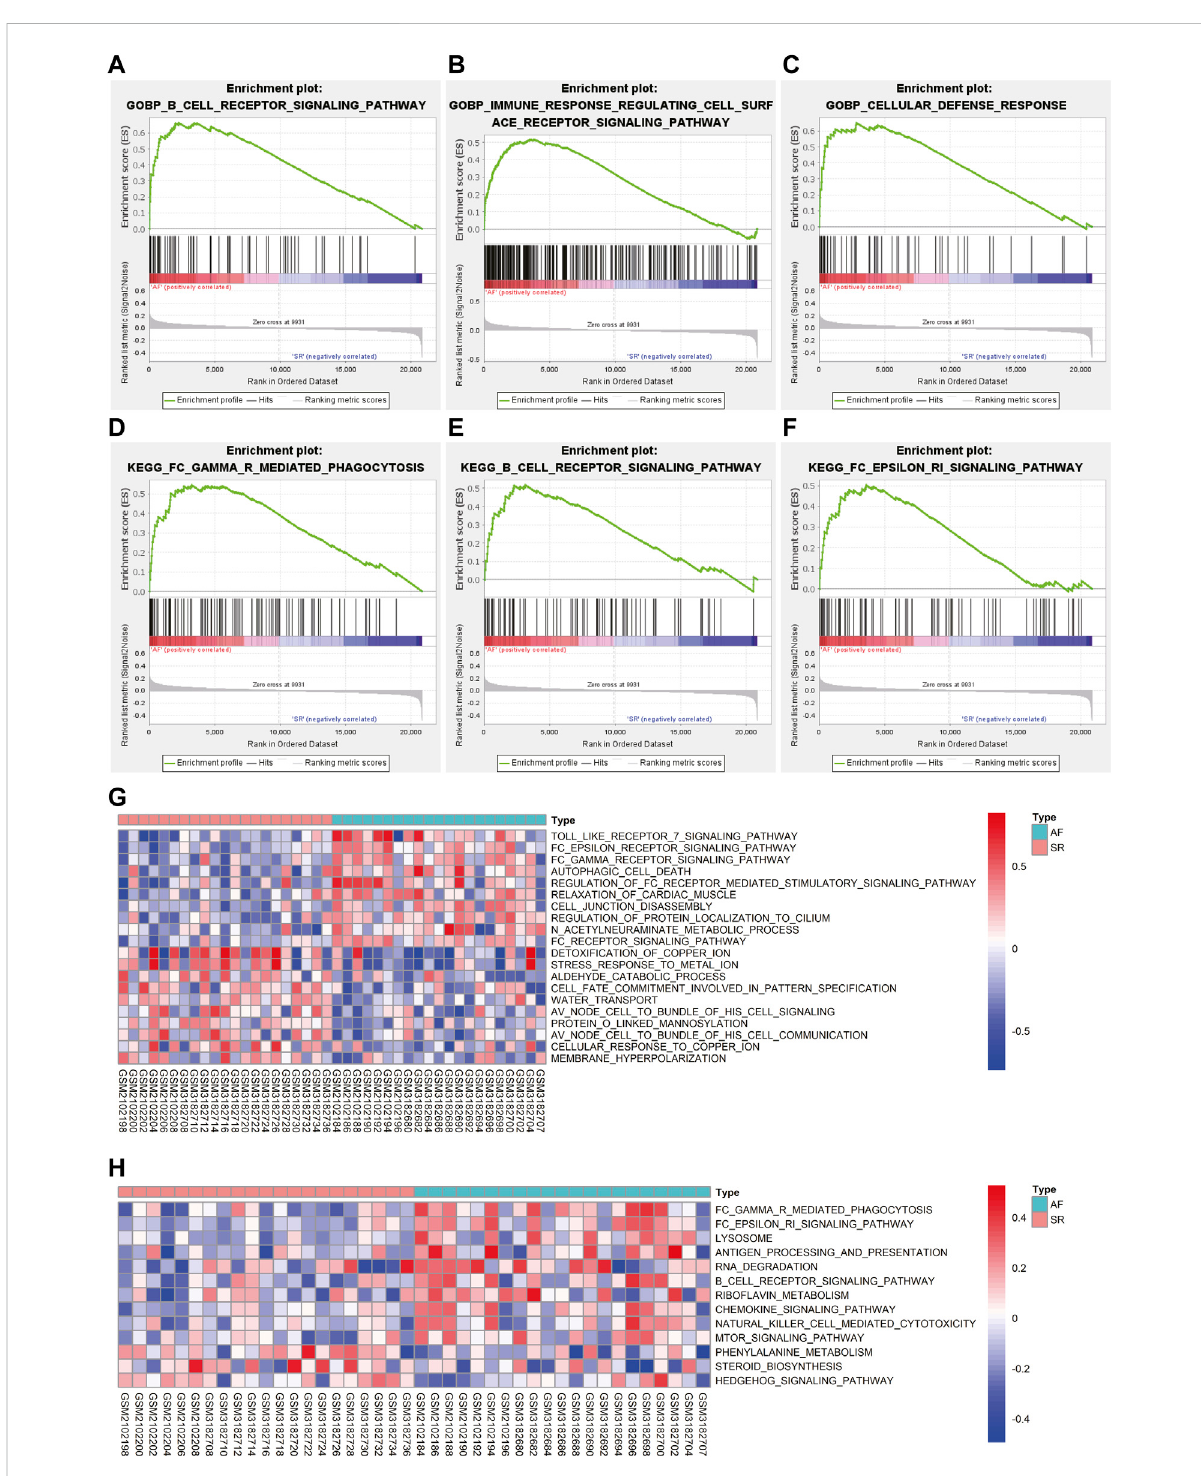
FIGURE 3 The results of GSEA and GSVA. (A – C) The results of GSEA revealed the GO-BP terms signi fi cantly enriched in AF group. (D – F) The results of GSEA revealedtheKEGGpathwayssigni fi cantlyenrichedinAFgroup. (G) ThevariationsofGO-BPtermsbetweendifferentsampleswereanalyzedusingGSVAand thetop 20signi fi cantly differentGO-BP terms wereshown inthe heatmap. (H) The variations of KEGG pathwaysbetween differentsamples were analyzed using GSVA and the signi fi cantly different KEGG pathways were shown in the heatmap. GSEA: gene set enrichment analysis, GSVA: gene set